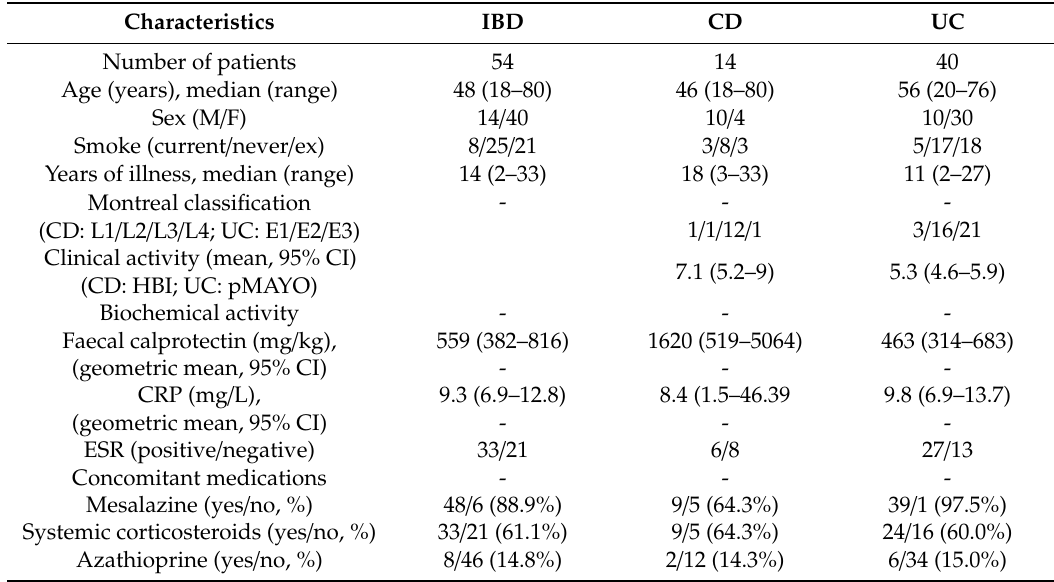
Table 1. Epidemiological features, clinical activity according to Harvey-Bradshaw index (HBI) and partial MAYO (pMAYO) score, biochemical activity and medications at baseline of the study